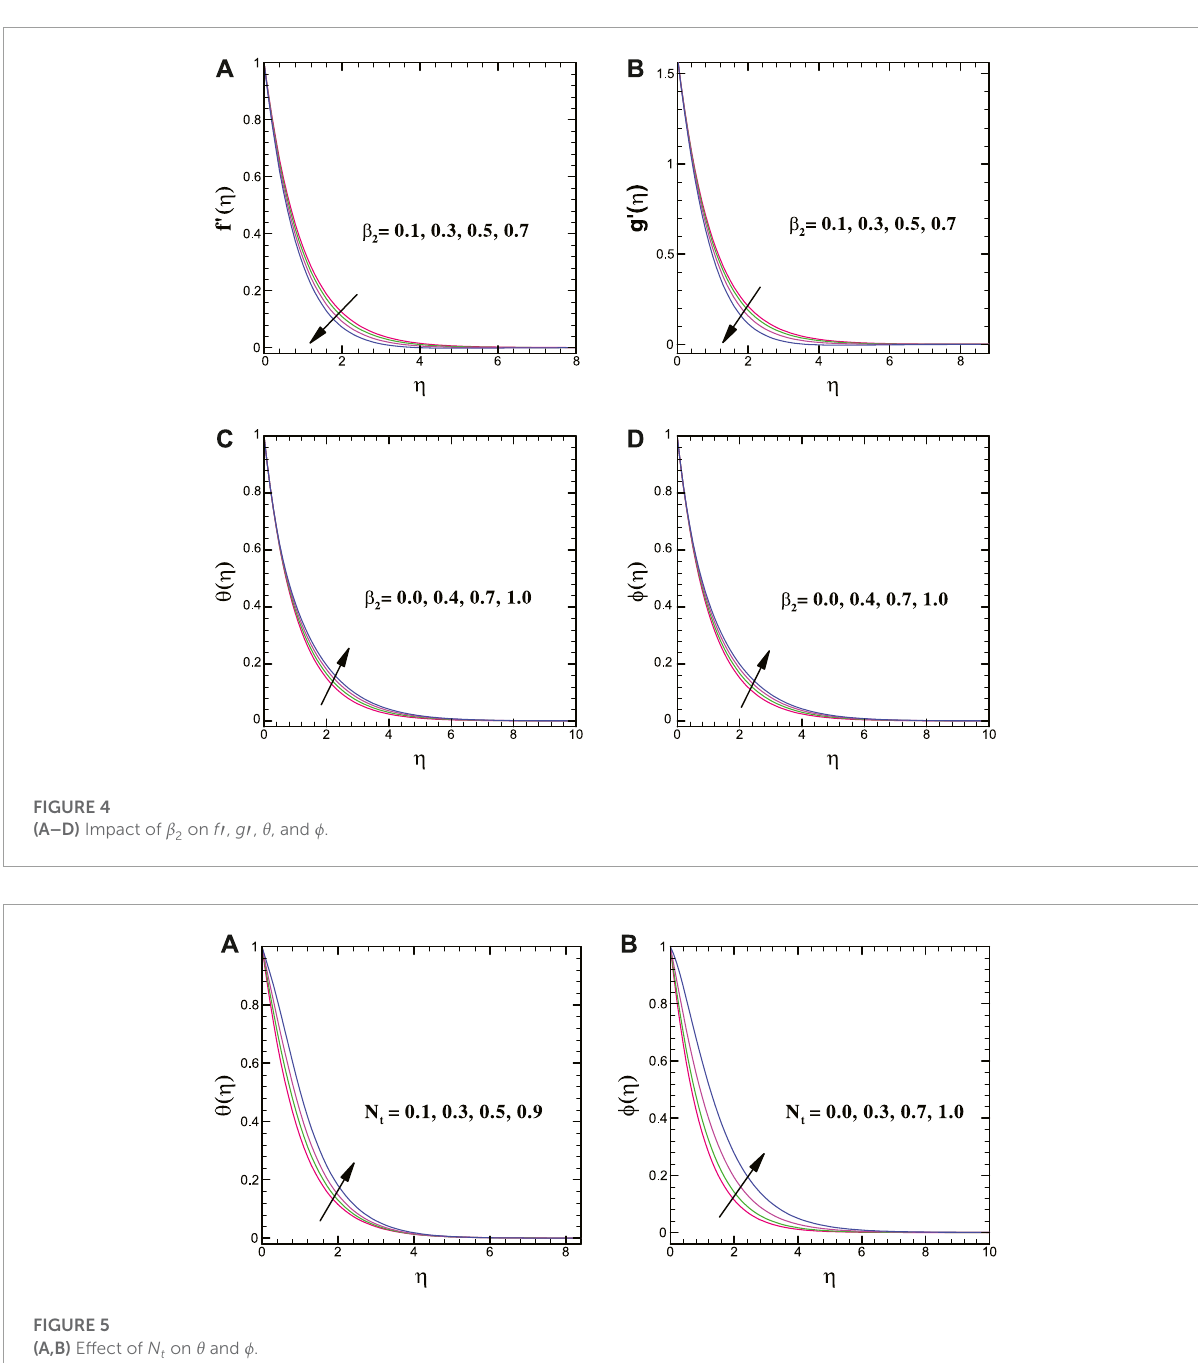
FIGURE 5 (A,B) Effect of N t on θ and ϕ